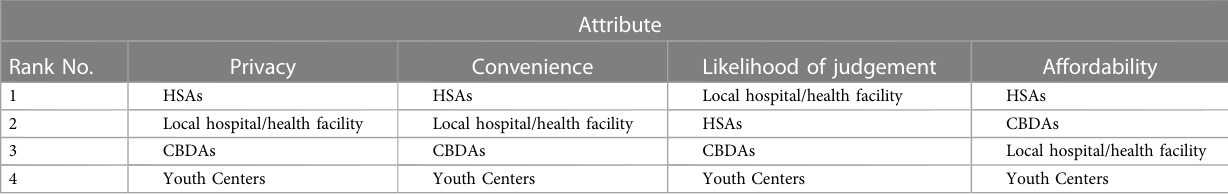
TABLE 3 Service delivery point (SDP) ranking exercise results. Rank